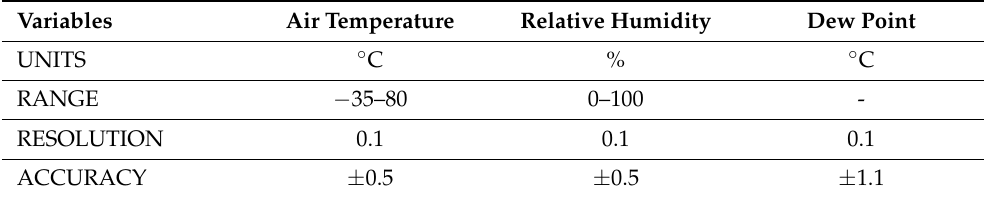
Table 2. Variables measured by fixed data loggers.